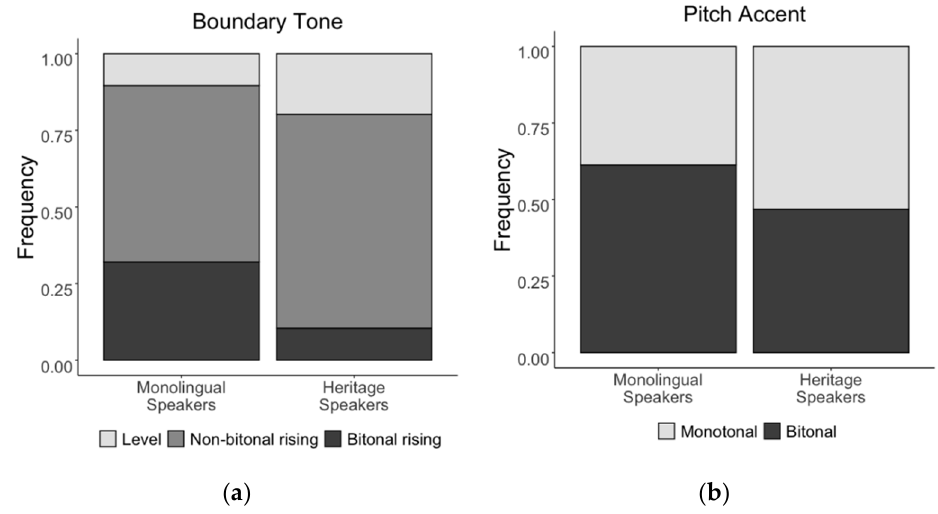
Figure 1. ( a ) Frequency of boundary tones across pitch accents; ( b ) Frequency of pitch accents in non-bitonal rising boundary tones.